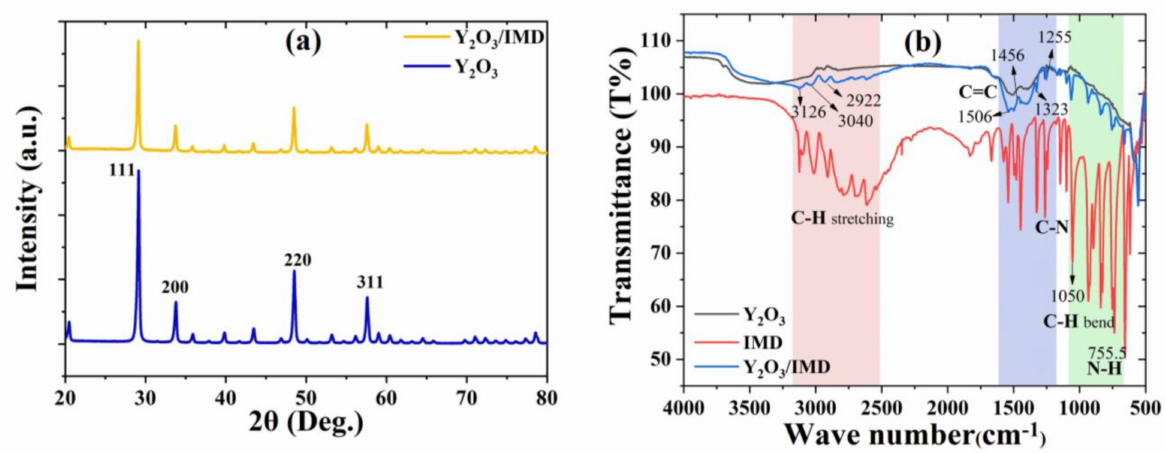
Figure 3. ( a ) XRD and ( b ) FTIR analysis of Y 2 O 3 and Y 2 O 3